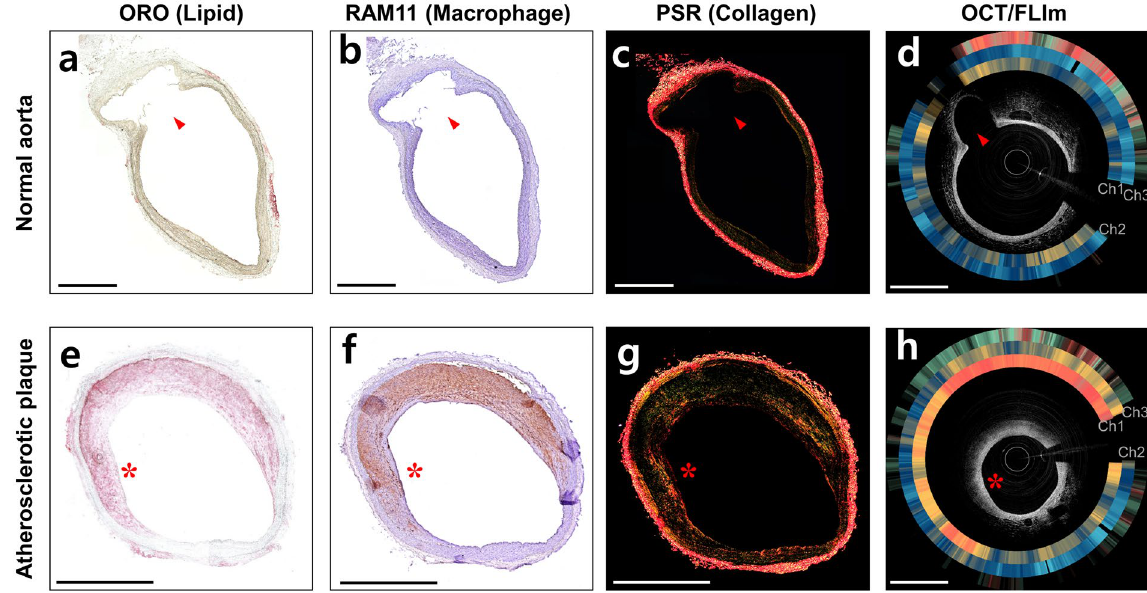
Figure 5. Histopathological staining and cross-sectional OCT/FLIm images of ( a – d ) normal aorta and ( e – h ) atherosclerotic plaque. (a, e) Oil red O (ORO) stained tissue that represents lipids (red color). ( b , f ) Immunohistochemistry with RAM 11 antibody (brown color) that represents macrophages. ( c , g ) Picrosirius red (PSR) stained tissue that represents collagen types I (yellow-orange birefringence) and III (green birefringence). ( d , h ) Cross-sectional OCT/FLIm images of rabbit aorta. Intensity-weighted fluorescence lifetime is expressed as rings from channels 1, 2 and 3 (in turn from inner to outer) outside the OCT images. Morphological landmarks, such as side branch (red arrows) and plaque shape (red asterisks), show the match between the histopathological sections and the in vivo OCT/FLIm cross-sectional images. Fluorescence lifetime colormap is the same as given in Fig. 4. Scale bars: 1